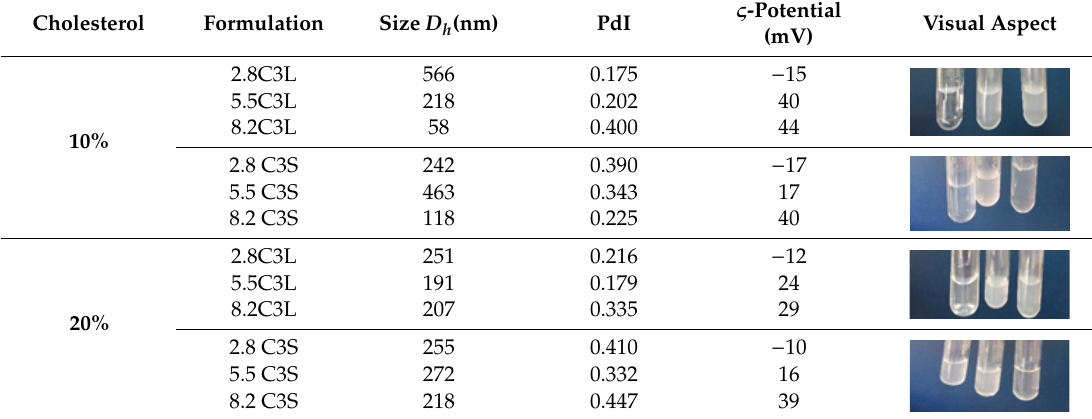
The DLS results corresponding to the LM mixtures indicate that catanionic vesicles were spontaneously formed after mixing the two monocatenary surfactant aqueous solutions in a ratio of 8/2 and 2/8. The PdI values indicate that both 8.2LM and 2.8LM contained a monodisperse population of small vesicles with a mean D h of 121 nm and 190 nm, respectively. The DLS results were supported by visual observations, as the 8.2LM and 2.8LM dispersions were bluish in color, which is typical of catanionic vesicles sized in the visible wavelength range (Table 3, Figure 5a) [25]. At an equimolar ratio, the mixed solution became very turbid and the surfactant mixture was prone to precipitate. When all positive charges are neutralized by the negative ones, the hydrophobic content of the system is very high, leading to phase separation. Precipitation when the surfactant